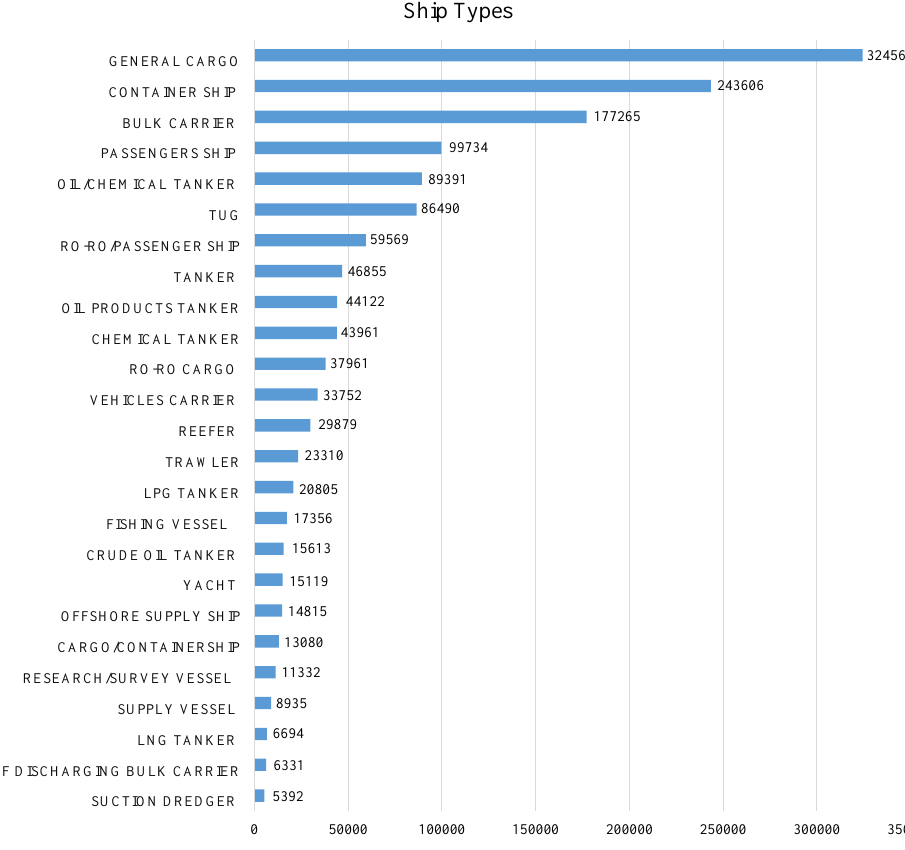
Figure 4. Samples by classes in the MARVEL